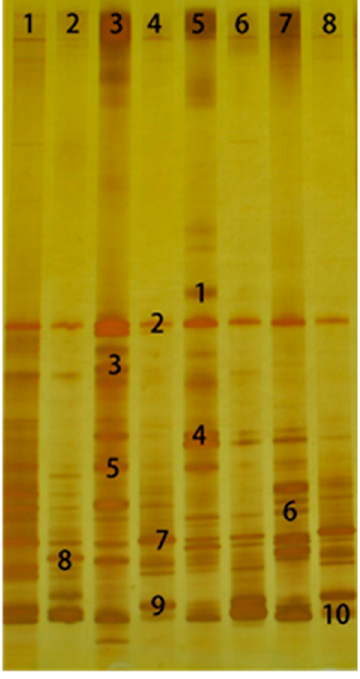
Figure 3. DGGE analysis of PCR-amplified 16S rDNA fragments of different moisture Lolium multiflorum Lam. silage after aerobic exposure for 3 days. Lane 1, control group at 35% DM; lane 2, formic acid group at 35% DM; lane 3, LP-treated group at 35% DM; lane 4, LB-treated group at 35% DM; lane 5, control group at 25% DM; lane 6, formic acid group at 25% DM; lane7, LP-treated group at 25% DM; lane 8, LB-treated group at Table 7 . Sequences analysis of DNA recovered from single band in DGGE fingerprints of silage after aerobic exposure for 3 days .